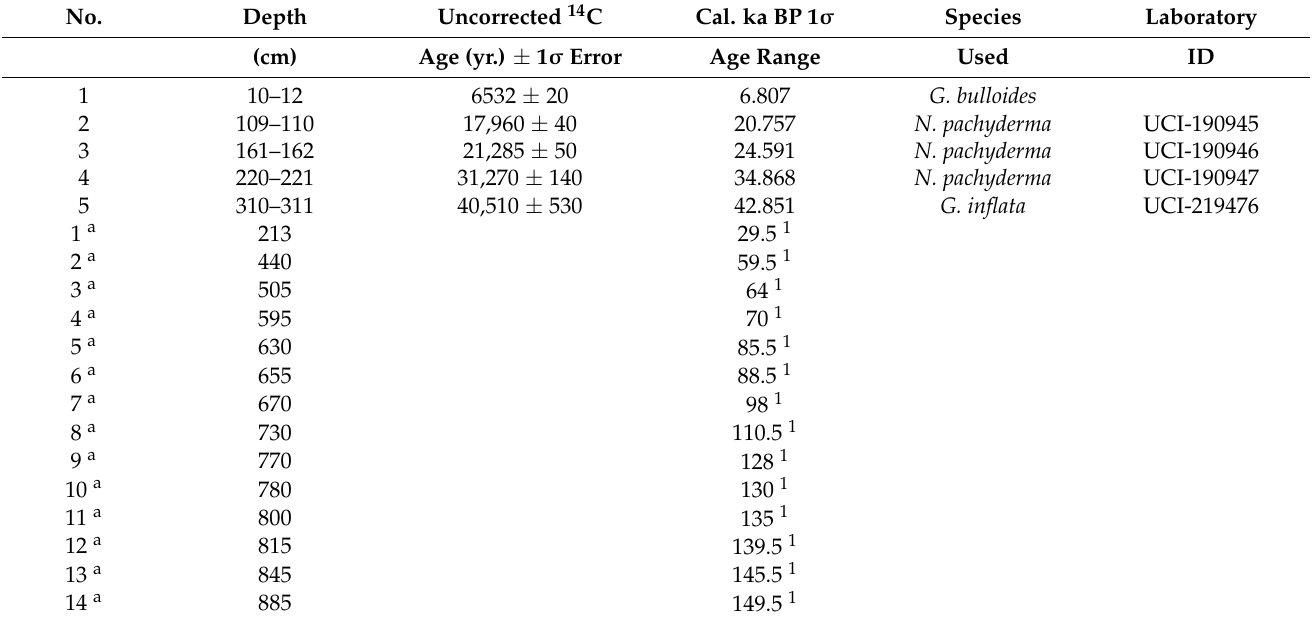
Table 2. 14 C-AMS dates and tie points used to construct the age model of core